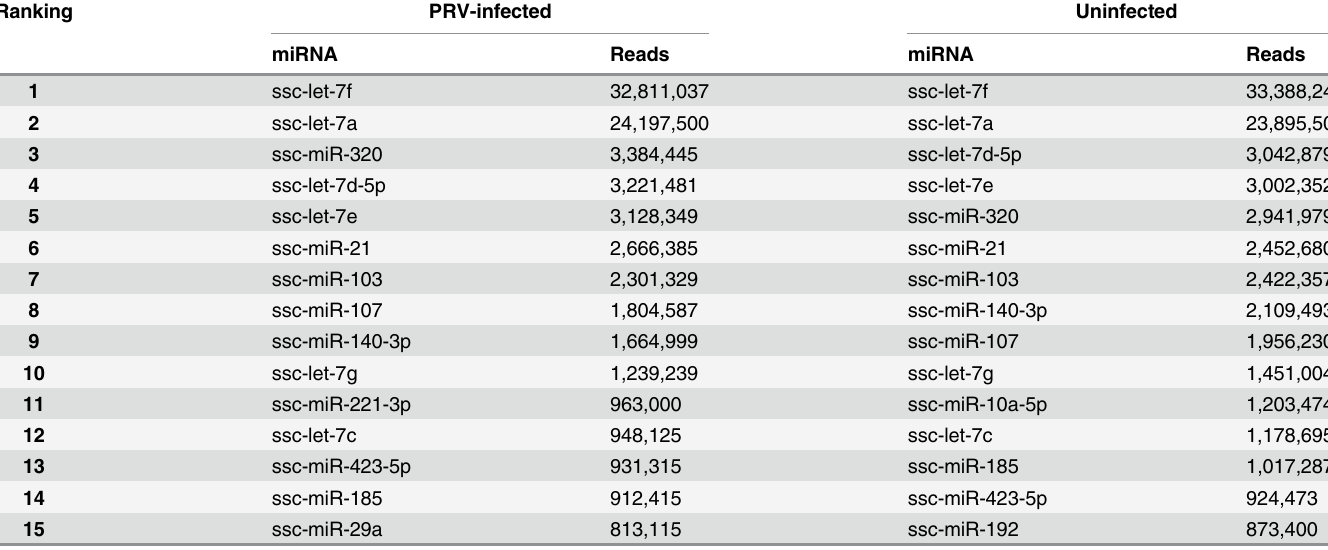
Table 4. Fifteen miRNAs most strongly expressed in PRV-infected and uninfected